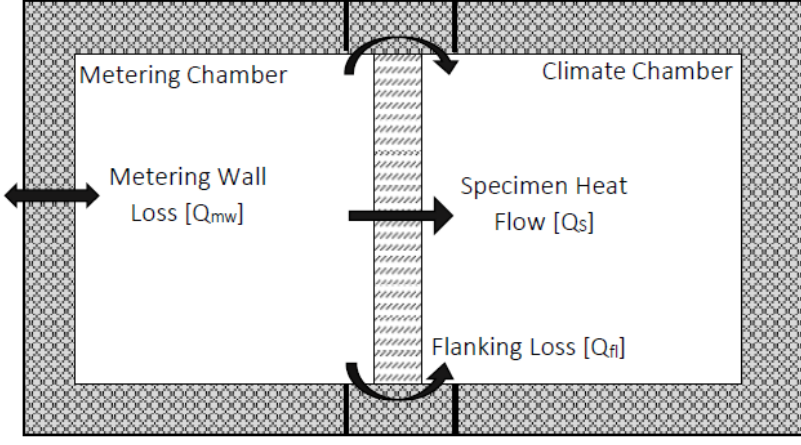
Figure 9. Scheme of heat flow paths.